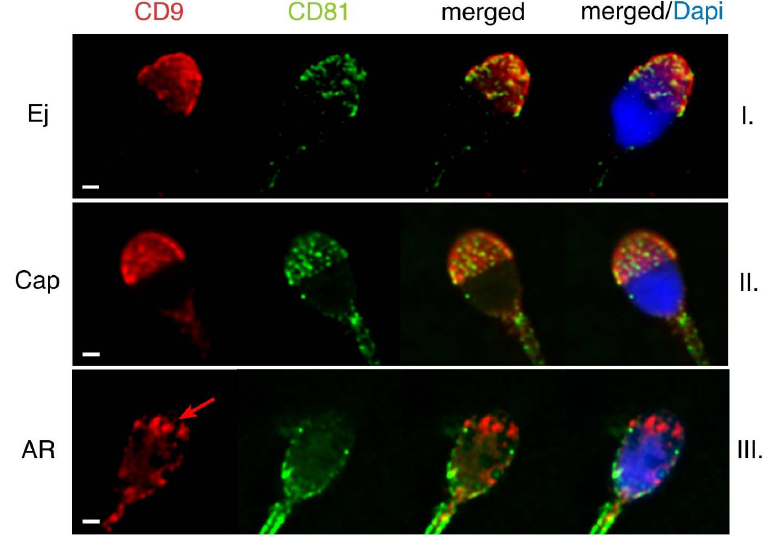
Figure 4. Dynamics of CD9 and CD81 in their mutual localization in human sperm captured by confocal microscopy. ( I ) In ejaculated sperm, both CD9 (red) and CD81 (green) are present in the apical acrosome. ( II ) During capacitation no changes in localization of both proteins occur. ( III ) After completing AR, the plasma membrane covering the apical acrosomal area and the outer acrosomal membrane are both lost. The fluorescent signal of CD9 is located over the equatorial segment (red arrow) and CD81 disappears from the acrosome. After the acrosome reaction, CD81 is mainly detectable in the postacrosomal region of human sperm head. DAPI (blue). Scale bar represents 1 μm.